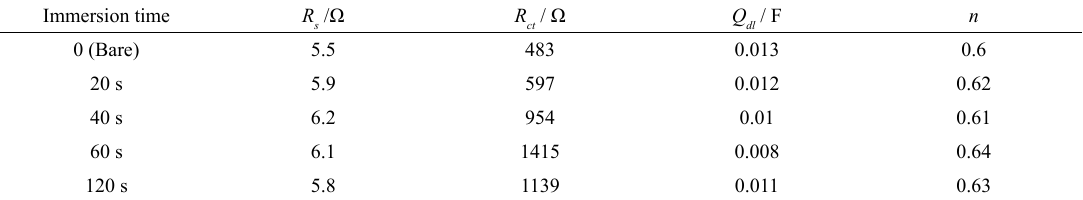
Table 2. Impedance parameters of different immersion times for the coatings cerium in 3.5 wt. % NaCl solution. Coatings were prepared by immersion in cerium solution in 25 °C.